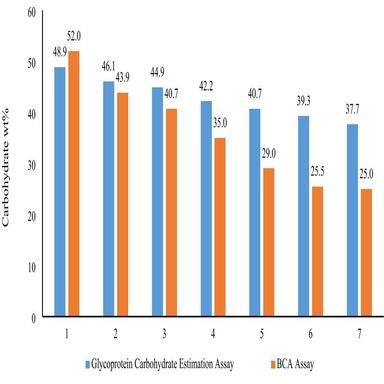
Estimated composition of purified dextran-BSA conjugate using Process C.